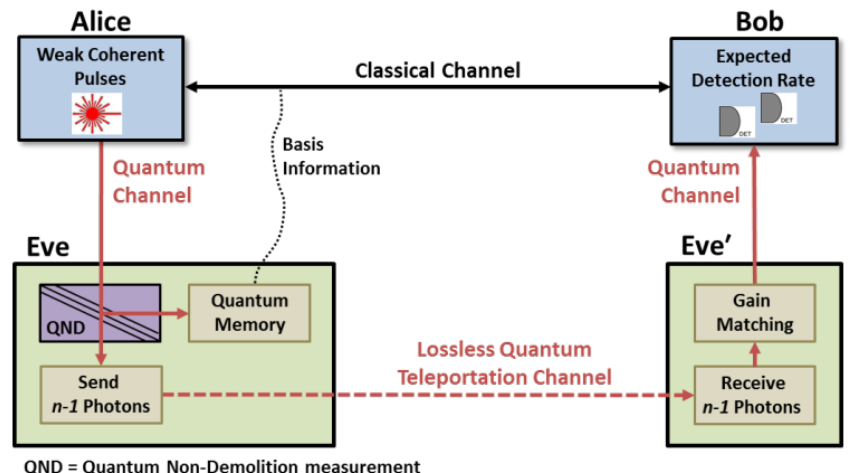
Figure 2. The eavesdropper (Eve and Eve′) is shown conducting a Photon Number Splitting (PNS) attack against the QKD system (Alice and Bob). Adapted with permission from [9], Copyright IEEE, 2016.